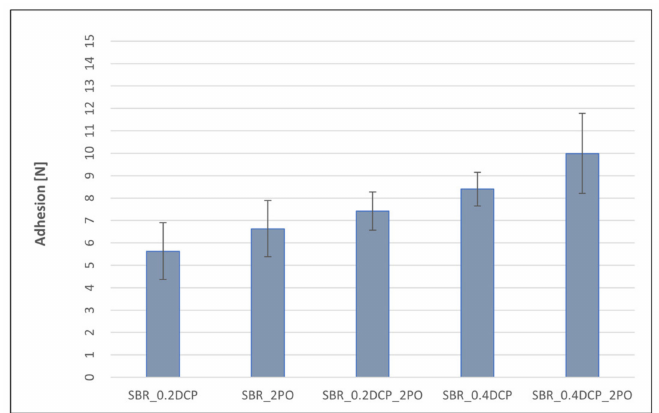
Figure 14. Influence of the modified resin addition on adhesion between peroxide SBR vulcanizates and silver